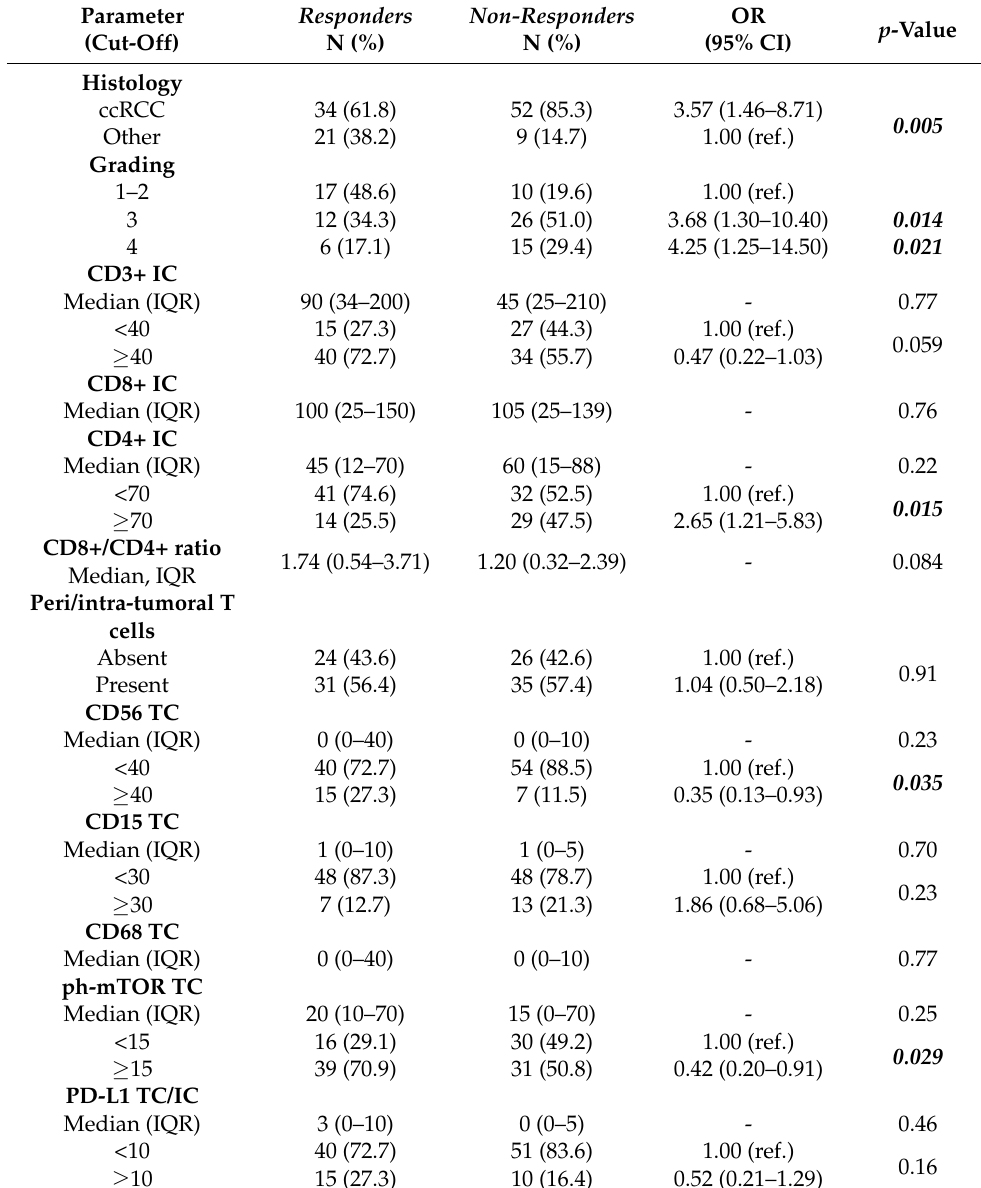
Table 2. IHC results of primary tumor and metastases samples between responder and non-responder mRCC